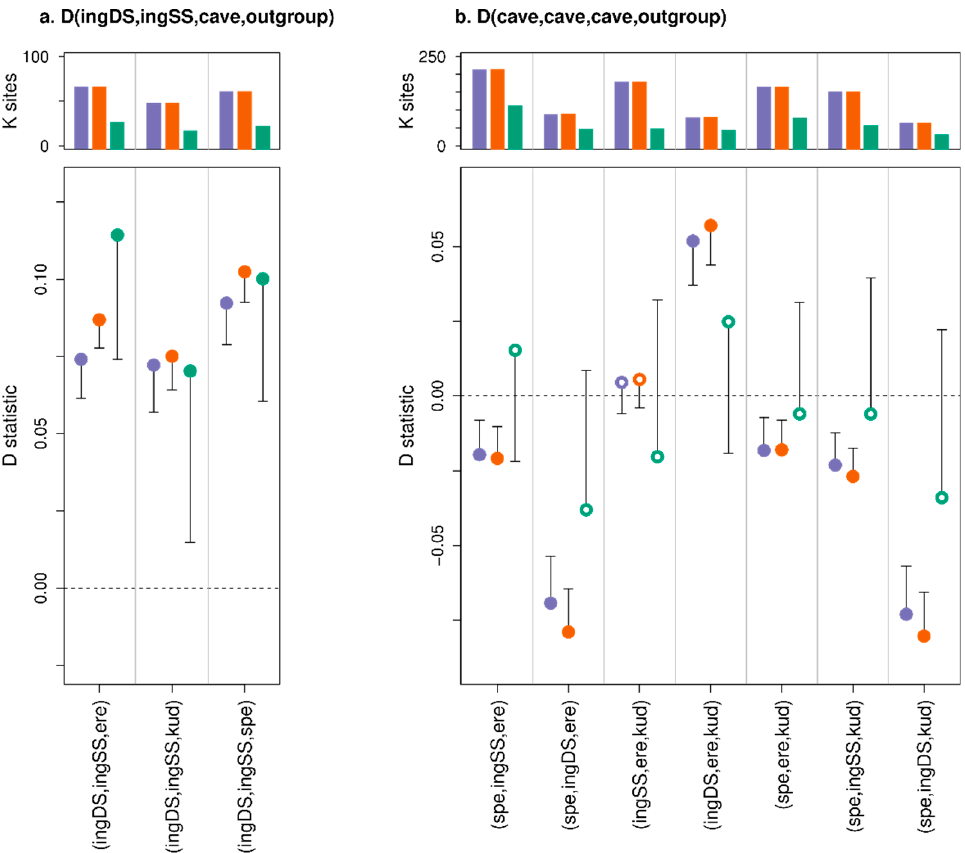
Figure 5. Effect of Consensify on D statistic tests of admixture among cave bear populations and datasets. The plot layout and annotation are consistent with Figure 4. Comparisons are described by x-axis labels, with the first three letters of each cave bear taxon indicating their respective positions as (P1,P2,P3). The outgroup (P4) is the Asiatic black bear. The left panel ( a ) shows comparisons with datasets generated from the same ingressus cave bear individual as P1 and P2, corresponding, respectively, to datasets generated using either the single-stranded (SS) or the double-stranded (DS) library protocol. The right panel ( b ) shows all comparisons compatible with the cave bear phylogeny (see Figures 1 and 3): ((( ingressus , spelaeus ), eremus ), kudarensis ). Note that y axes are not consistent between panels ( a , b ).